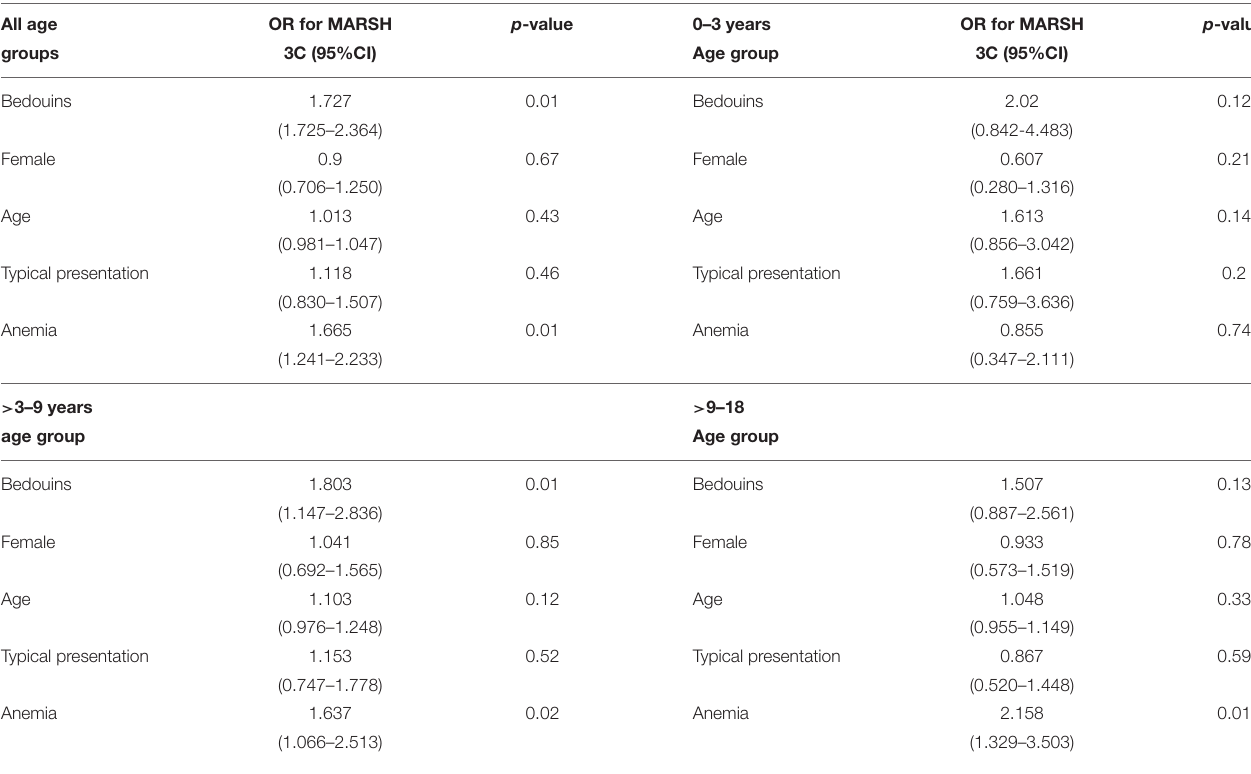
TABLE 4 | Regression